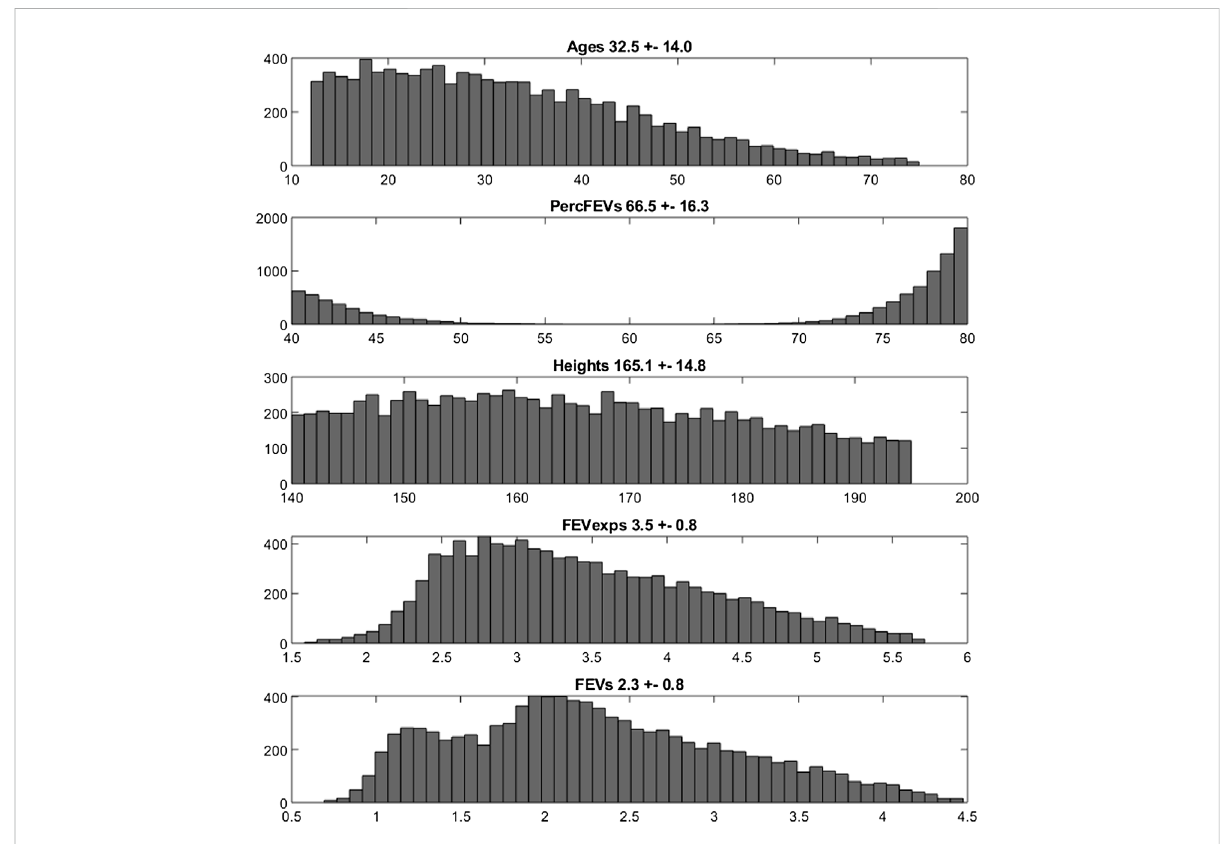
FIGURE 2 Histograms of frequencies of the simulated demographic and related-disease characteristics for the population undergoing 12 μ g of formoterol via